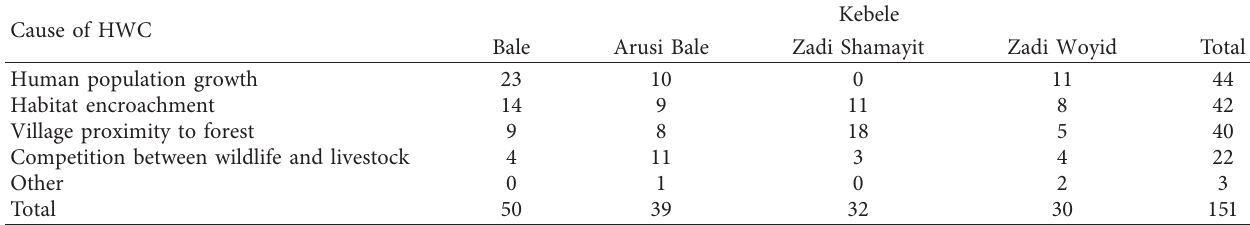
Table 5: Response rate on the major causes of HWC in the study area.